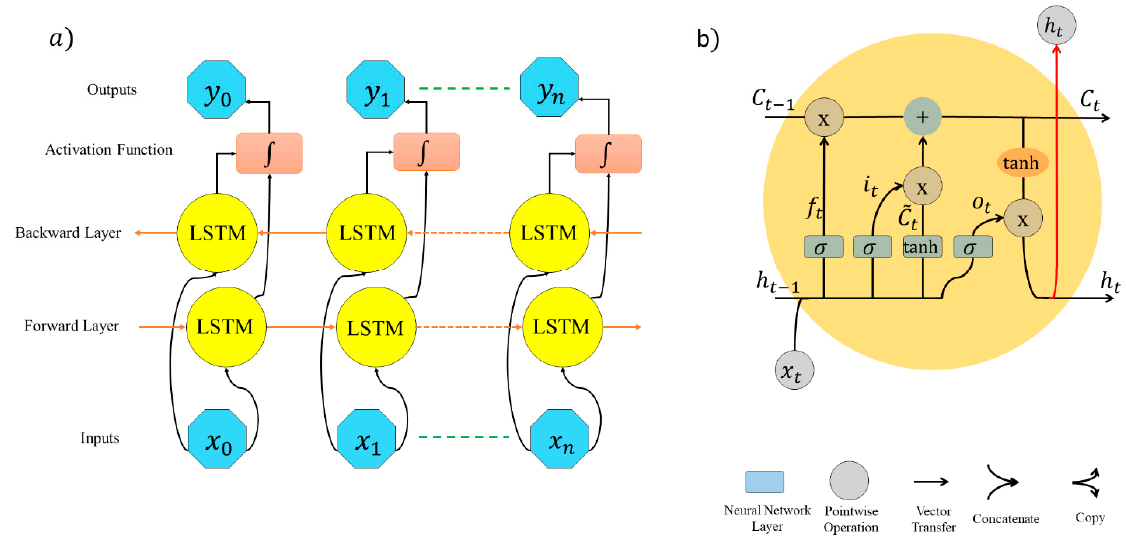
Figure 5. ( a ) Architecture of the Bi-LSTM neural network ( b ) Functions inside a single LSTM cell.